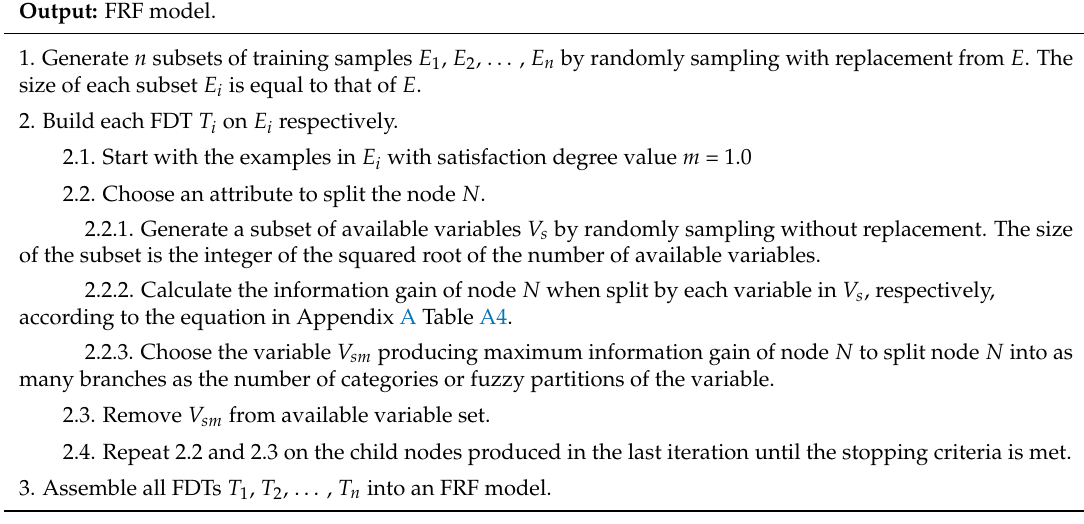
Table A2. Steps to train a FRF